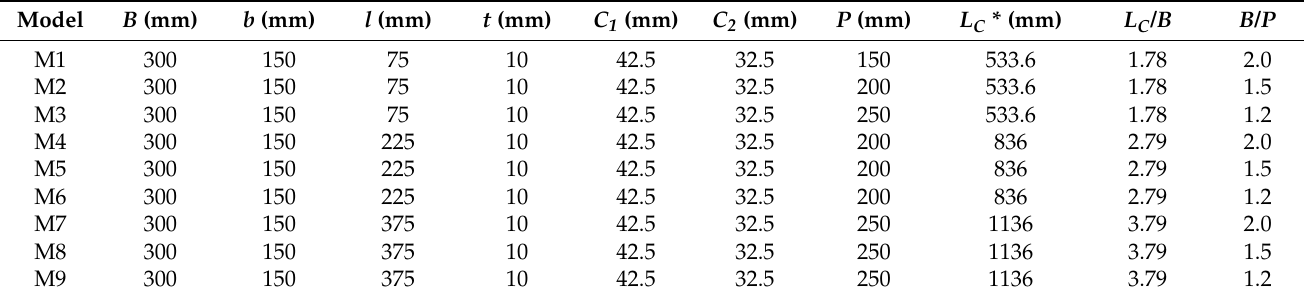
Table 1. Characteristics of the weir models.